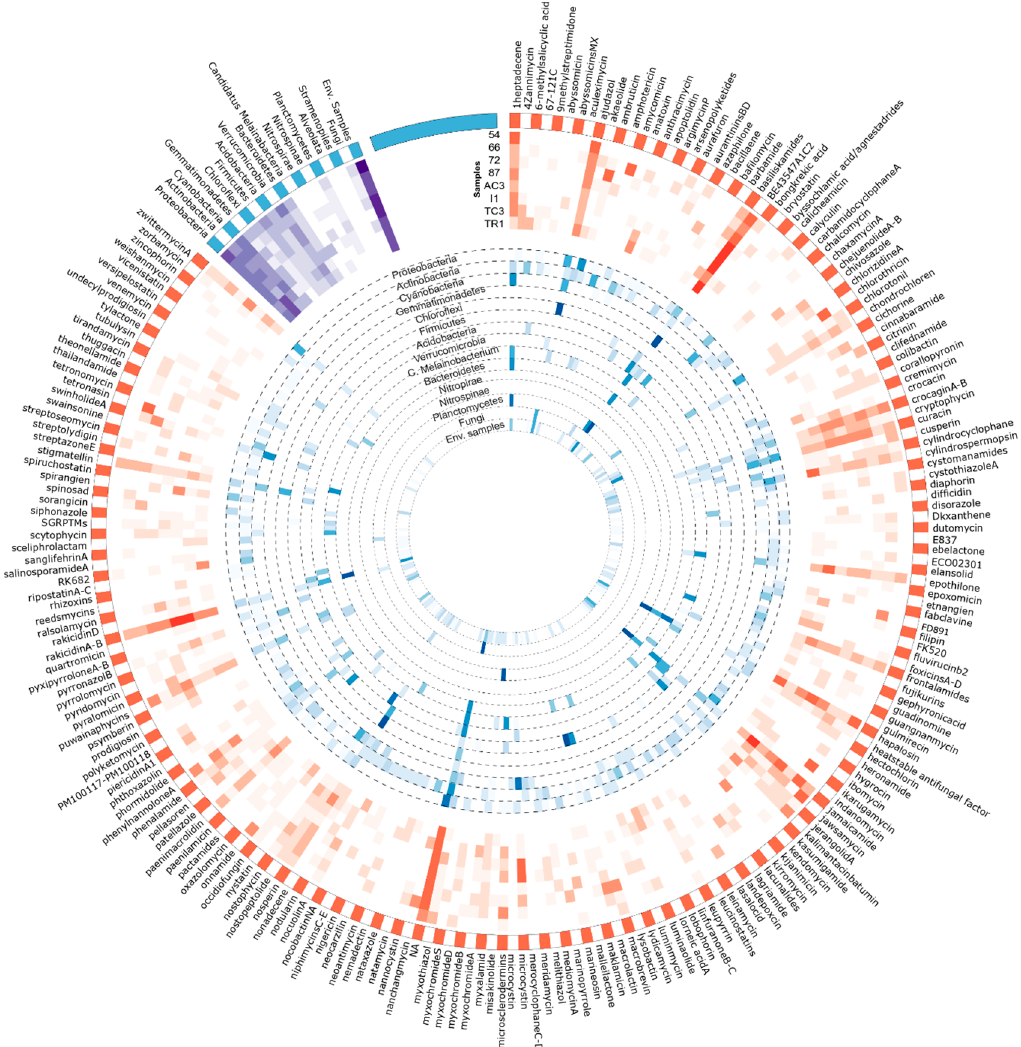
Figure 8. Circular visualization of the distribution of KS domain OTUs identified against the MiBIG database and its correspondent taxonomical provenience. Figure produced using circos software [45]. Read the figure clockwise, from the outside to the interior. The outside represents the metabolites assigned to the KS domain sequences by using the MiBIG database (orange and white). Heatmaps represent the sum of the metabolites assigned to the KS domain sequences for each sample (in red) and the relative abundance of its correspondent taxonomic provenience for each phylum (in blue). A third heatmap (in purple) represents the total number of metabolites from the KS domain with taxonomic provenience of each phyla per sample.